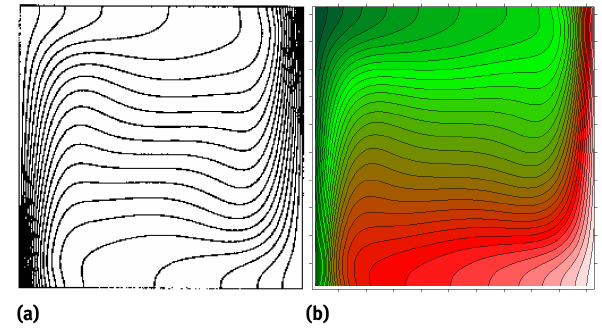
Figure 5: The comparison of temperature distribution ((a) the benchmark, (b) the results of the given paper) at Re = 10 5 .